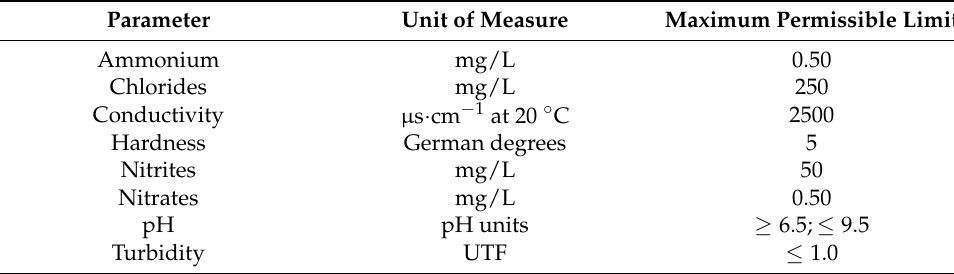
Table 4. Calibration data and quantification